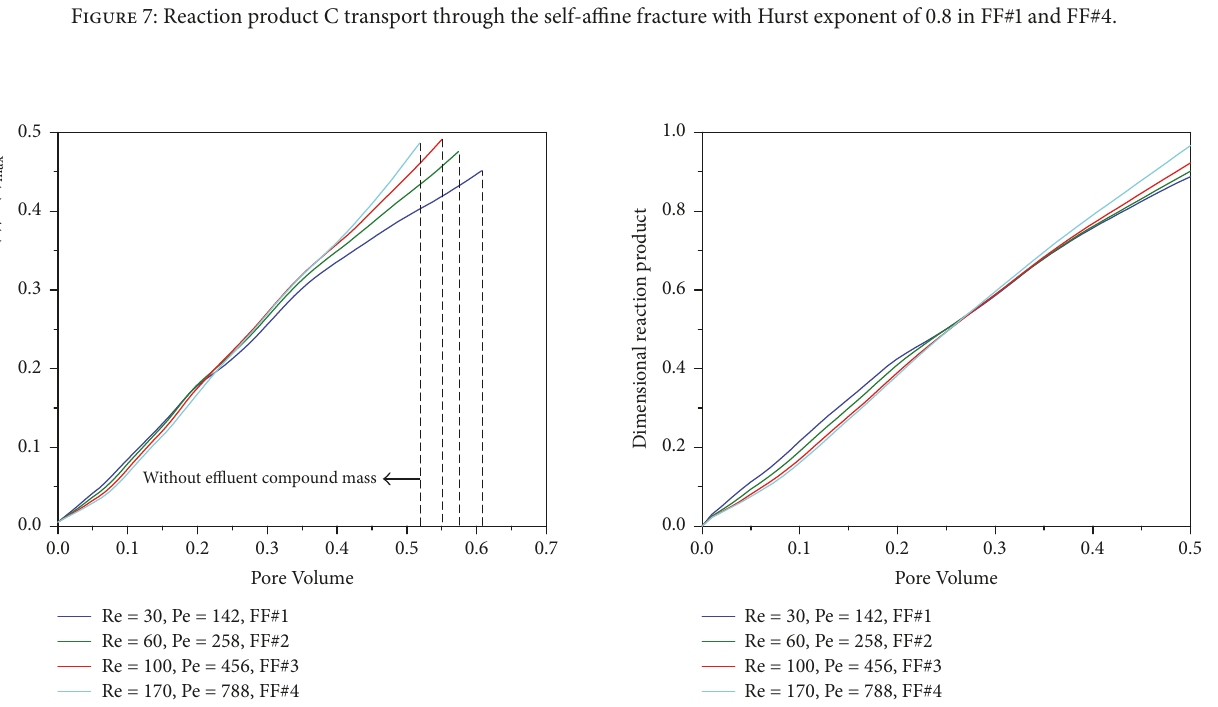
Figure 9: Dimensional reaction product mass for the nonreaction transport under the different flow fields in the single self-affine fracture with Hurst exponent of